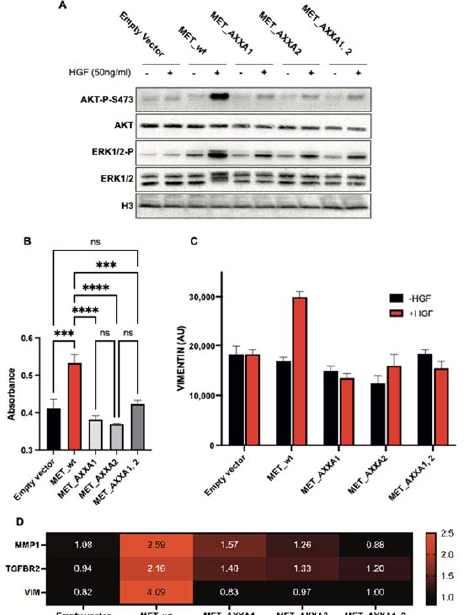
Figure 6. MET CXXC mutants are biologically inactive. ( A ) Stable TOV112D cells expressing either the wt_MET or indicated AXXA mutants were treated with HGF. Proteins were resolved in 10–12% gels to assess the activation levels of MET transducers, P ‐ AKT and P ‐ ERK1/2. Histone3 (H3) was used as a loading control. ( B ) Viability assay in the presence of HGF in indicated clones, measured by absorbance at 570 nm. Results are mean +/ ‐ SEM with N = 6. ANOVA with Tukey’s post hoc test was performed to compare different groups with ns: not ‐ significant; ***: p < 0.001; ****: p < 0.0001. ( C ) Flow cytometry data in permeabilized cells assessing the amount of vimentin protein expression in wt_MET or CXXC mutants treated with 50 ng/ml of HGF for 48 h. Results are mean +/ ‐ SEM with N = 2. ( D ) Cells were treated with HGF for 6 h, and mesenchymal ‐ state ‐ associated gene expression was assayed by RT ‐ qPCR. The geometric mean of TBP and 18S gene expression was used for normalization. Results are presented as heatmap of gene expression relative to ‐ HGF